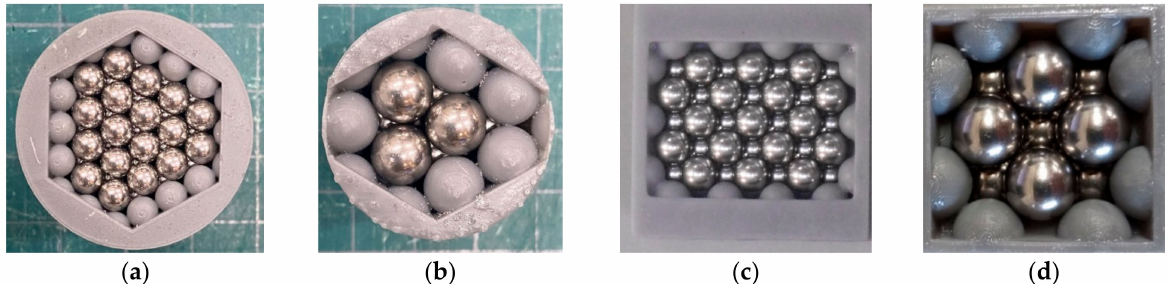
Figure 1. Test samples: ( a ) Hexagonal close-packed lattice ( d = 4 mm); ( b ) Hexagonal close-packed